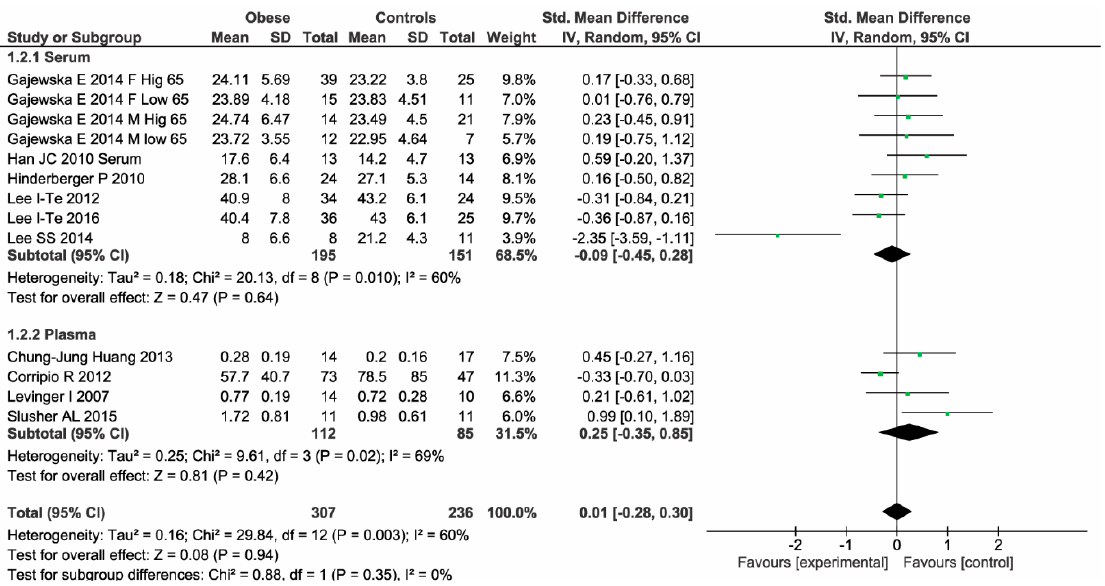
Table 3. Quality assessment (Newcastle–Ottawa scale) of 10 studies